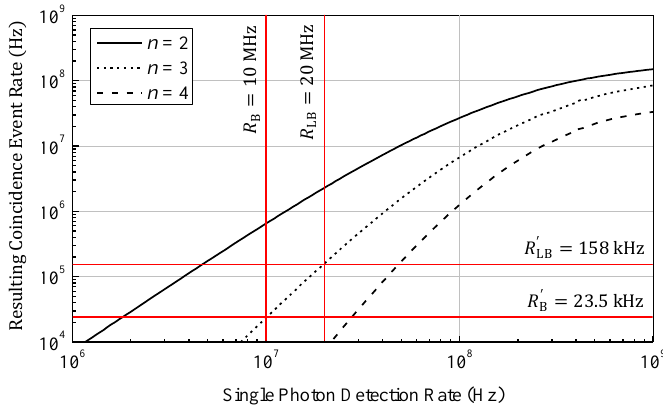
Figure 4. Photon coincidence event rate as a function of the single photon detections according to a statistical coincidence model based on photon inter-arrival times calculated for a coincidence time of 10 ns. The model takes into account the coincidence time, the coincidence depth, the number of SPADs, and the dead time of the SPADs. Highlighted values illustrate the improvement in SBR.